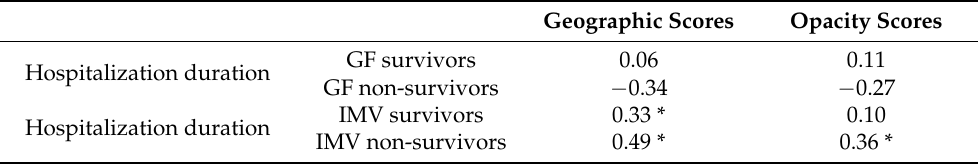
Table 4. Correlation (R) of geographic and opacity CXR scores for hospitalization, IMV on and post-IMV durations. * p <